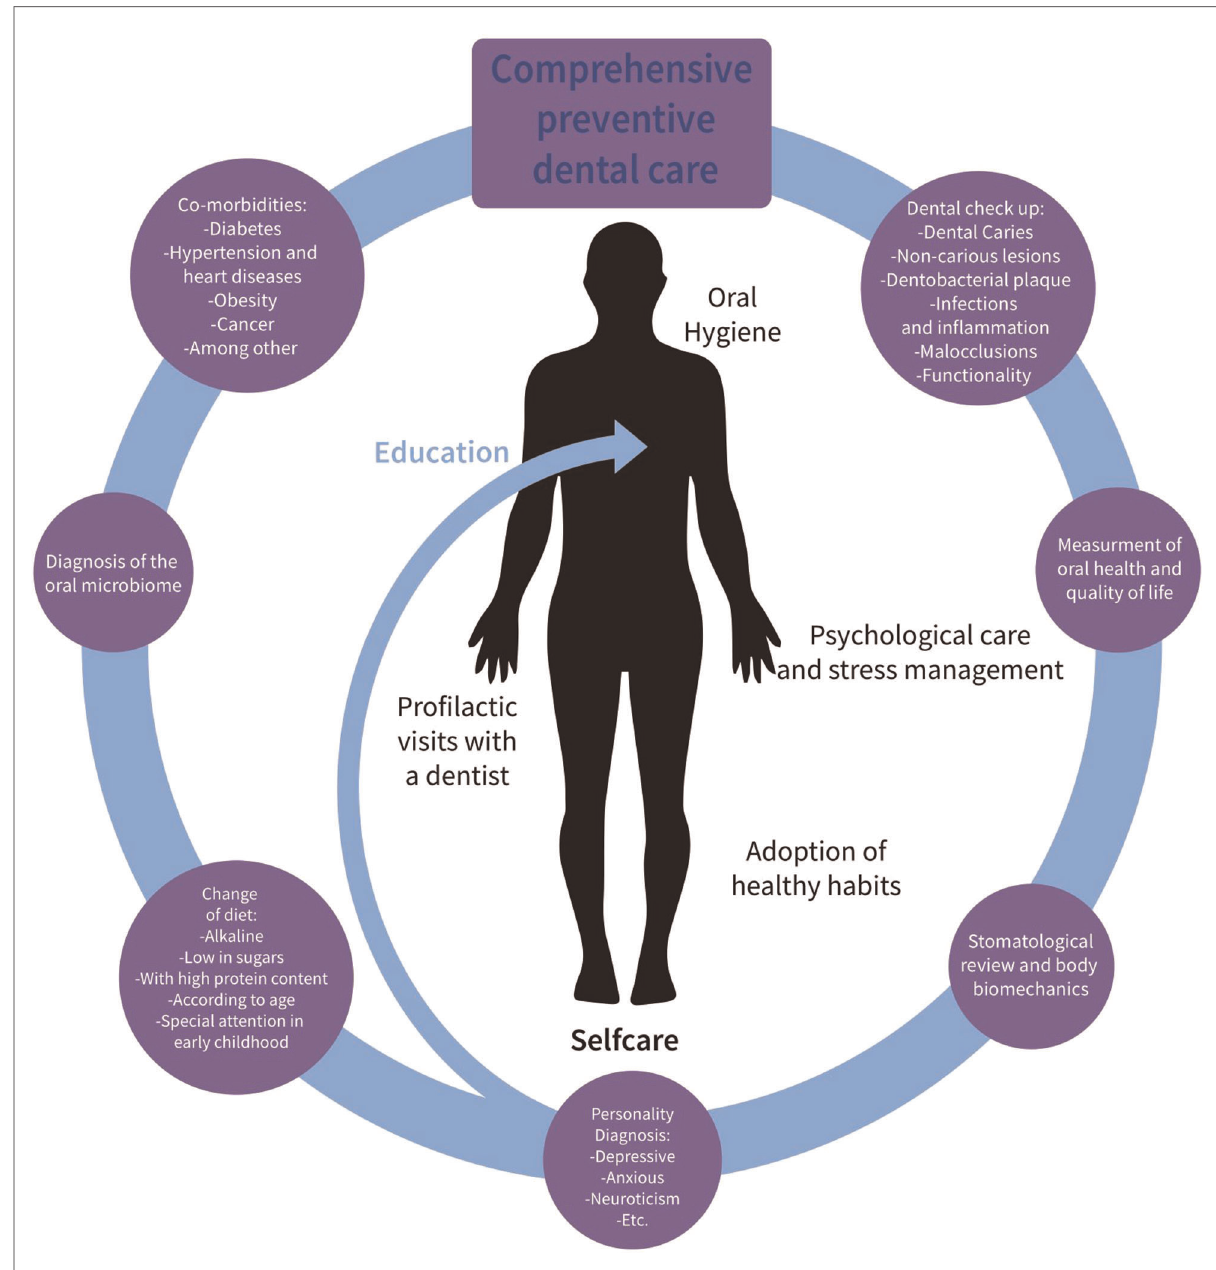
FIGURE 2 Comprehensive attention model through oral